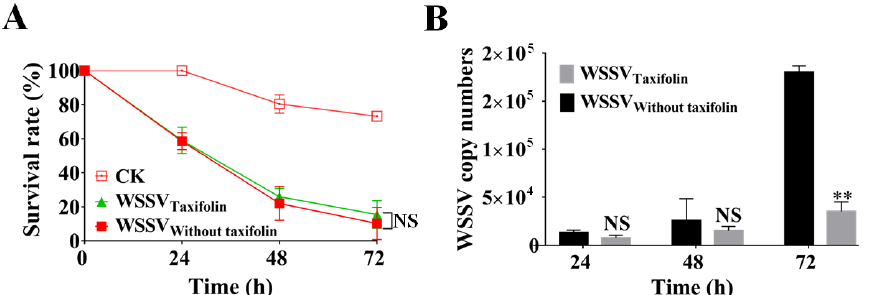
Figure 8. Dietary supplementation with taxifolin could inhibit the WSSV replication in shrimp larvae. After seven days of dietary supplementation with taxifolin, shrimp larvae were challenged with WSSV. Afterward, the WSSV-infected shrimp continued to be fed with or without taxifolin for three days. ( A ) The survival rate of WSSV-infected shrimp was analyzed. ( B ) Quantification on copy number of WSSV genome was tested every 24 h. Each value was represented as the mean ± SD. The p value was determined by Student’s t -tests. ** p < 0.01; NS p > 0.05.